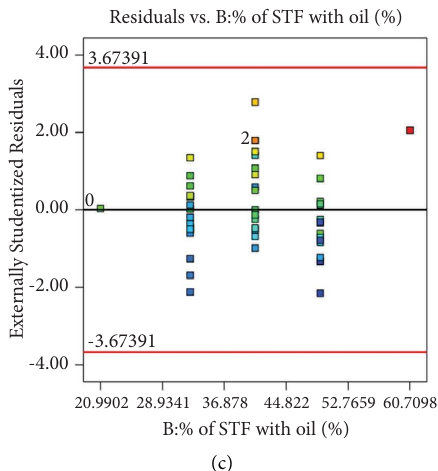
Figure 4: (a) Residuals vs. predicted values for complex viscosity. (b) Box–Cox plot for complex viscosity. (c) Residuals vs. process parameter for complex viscosity.